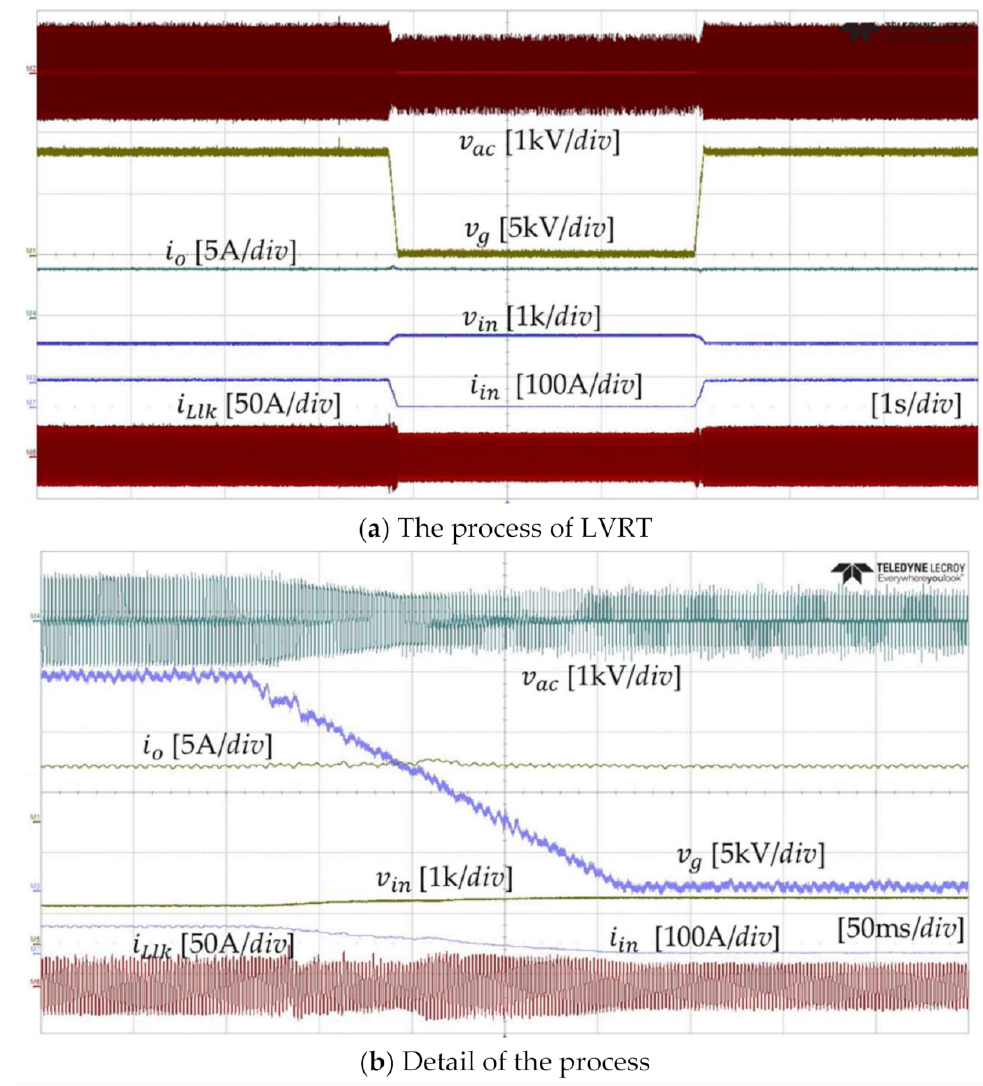
Figure 29. Experimental result of the process of LVRT (Grid voltage drops